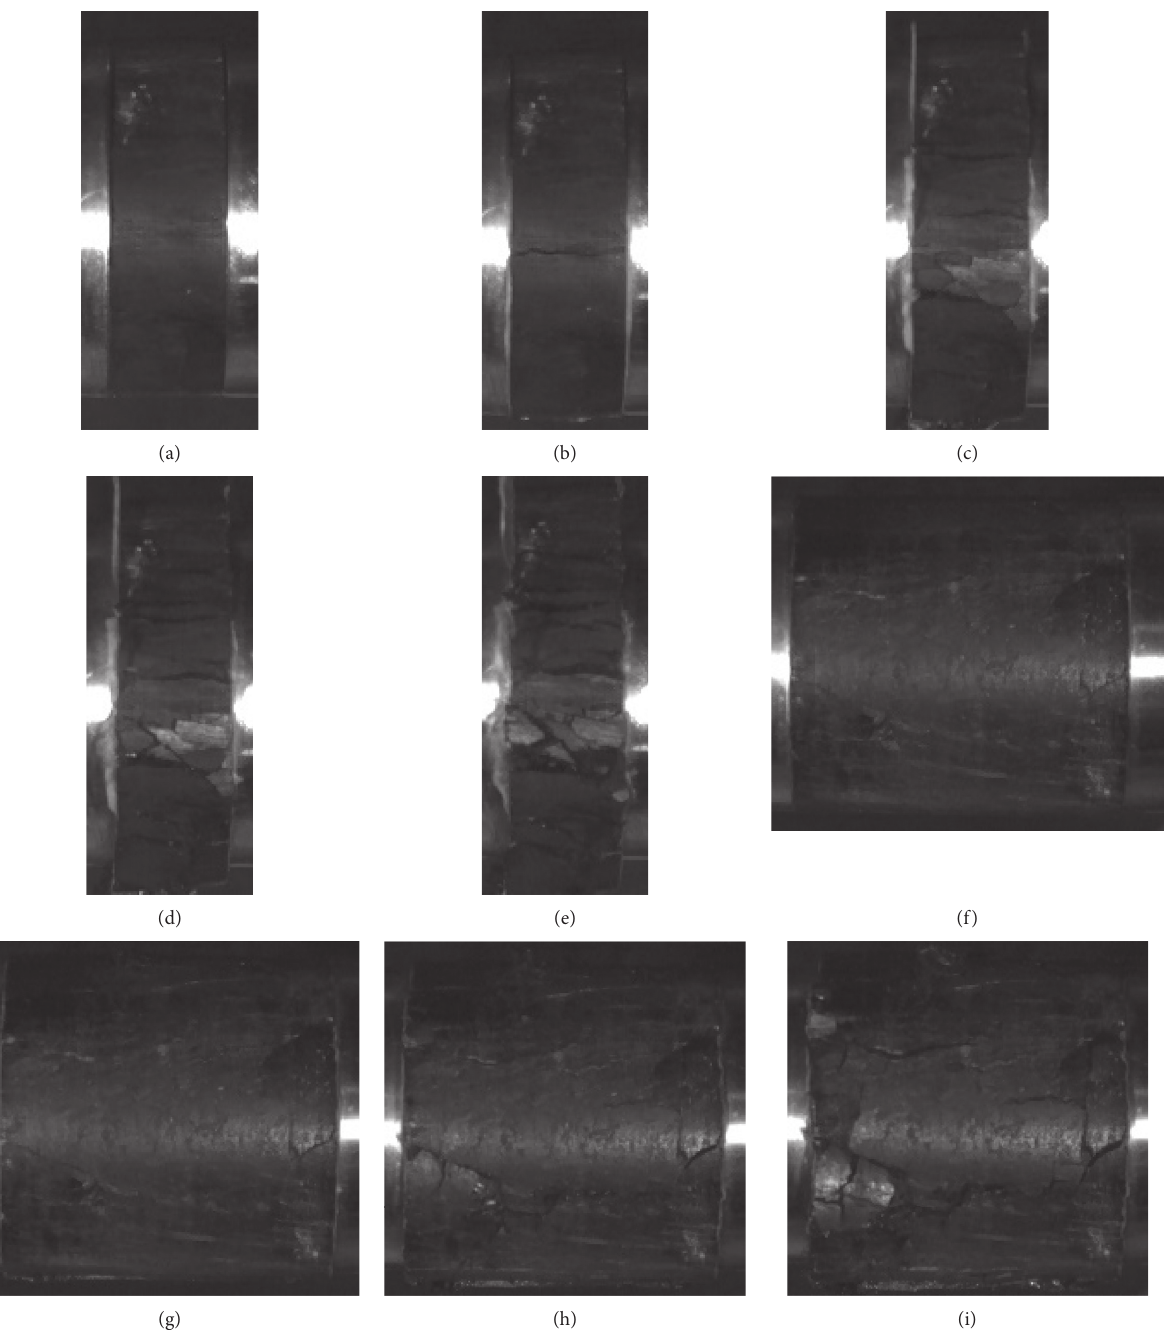
Figure 7: Photos of the failure process of two groups of coal samples with different L / D ratios by a high-speed camera. (a) Sample D-0.3-3 before loading. (b) Axial split crack propagation. (c) Secondary crack propagation. (d) Crack cross-linking. (e) Sample failure. (f) Sample D- 1-3 before loading. (g) Cracks development due to compression and expansion. (h) Main crack propagation. (i) Crack cross-linking results in specimen